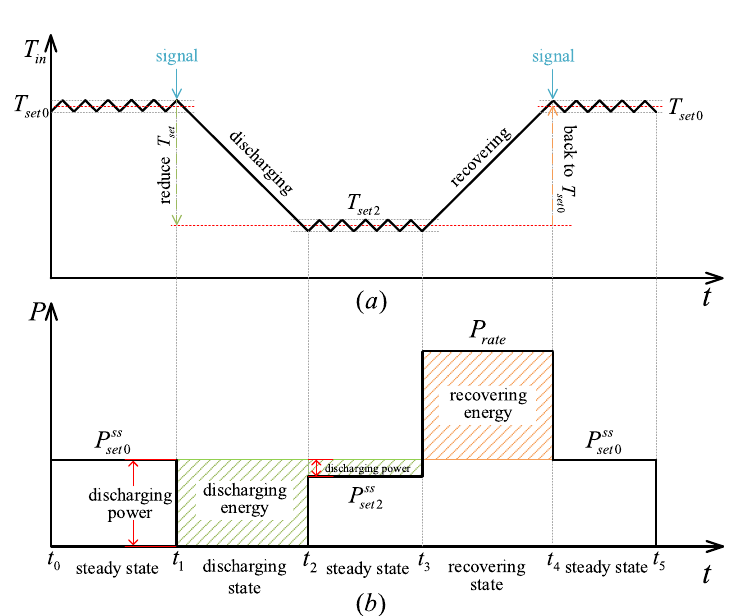
Fig. 5 Discharging process of the VESS in heating mode: ( a ) the varying curve of the indoor temperature and ( b ) the varying curve of the VESS ’ power